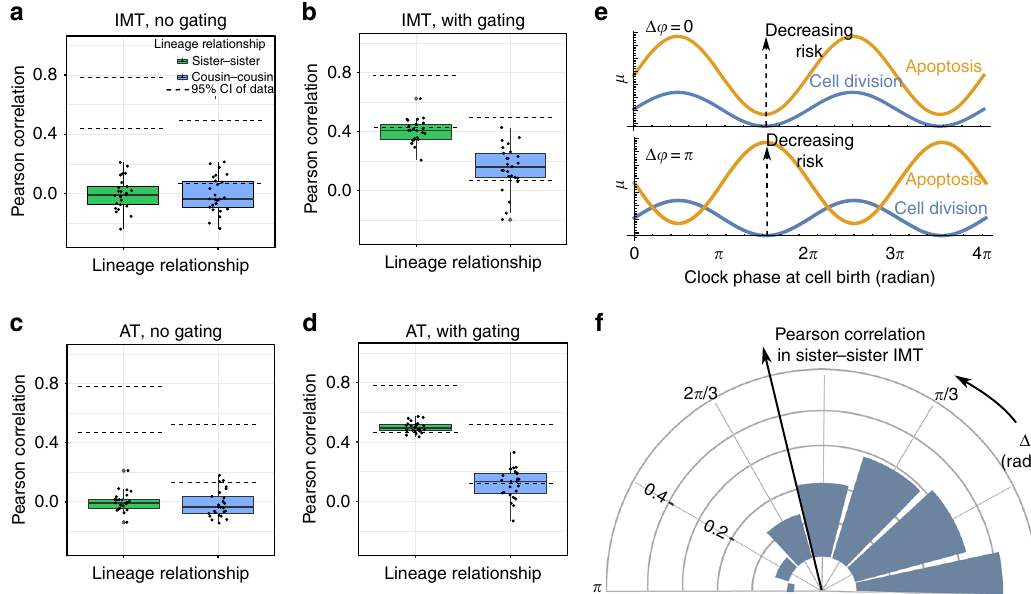
Fig. 7 In-phase gating of cell cycle and apoptosis pathways by the circadian clock. a Analysis of correlations in IMT generated by the model with no circadian gating and b with circadian gating of both the cell cycle and apoptosis pathways. c Analysis of correlations in apoptosis times (AT) generated by the model with no circadian gating and d with circadian gating of both the cell cycle and apoptosis pathways. Note that the high correlations observed in d cannot be obtained with a model that has only circadian gating of the cell cycle, and no coupling to cell death (see Supplementary Figure 11). In a – d the dashed lines represent the 95% con fi dence intervals of the respective correlations as calculated from the data while the boxplots represent the 1st, 2nd, and 3rd quartiles of the lineage correlations generated from 25 simulation runs. The fraction of simulation runs resulting in correlation values within the 95% con fi dence intervals remains approximately the same when increasing the number of simulations from 25 to 150 in b and d . e Two extreme examples of completely in phase gating (top) and completely out of phase gating (bottom) of the cell cycle and apoptosis pathways. The curves represent the parameter μ of the EMG function. Blue represents μ for cell division while yellow is the corresponding μ for cell death. Note that increasing μ corresponds to decreasing risk, for both division and death. f Effect of increasing the phase difference Δ φ between gating of cell cycle and cell death pathways on the sister correlations in IMT. The concentric rings indicate correlation levels and the blue bars denote the median correlations in IMT generated from 25 simulation runs, for different values of Δ φ . Parameters used to generate the simulated results are given in Supplementary section